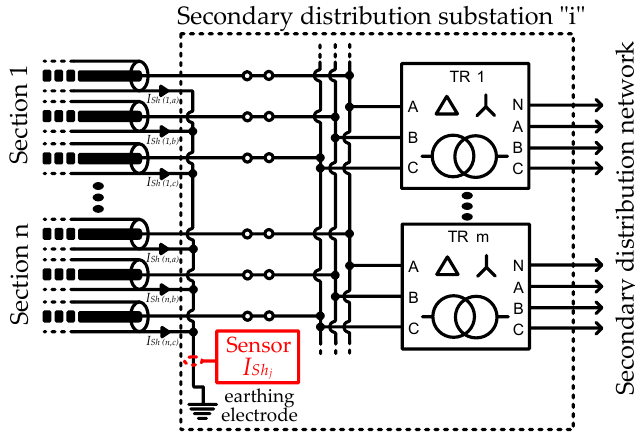
Figure 9. Proposed deployment for the Personal et al. [57]